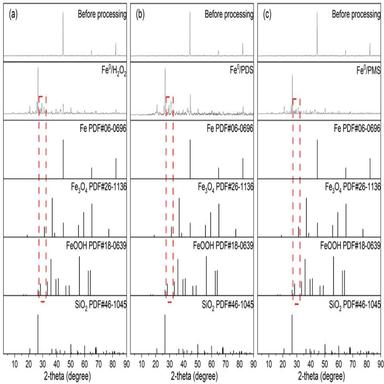
XRD spectra before and after the degradation of petroleum hydrocarbons in OBDC by the Fe0 /PMS (a), Fe0 /PDS (b), and Fe0 /H2O2 (c) systems.